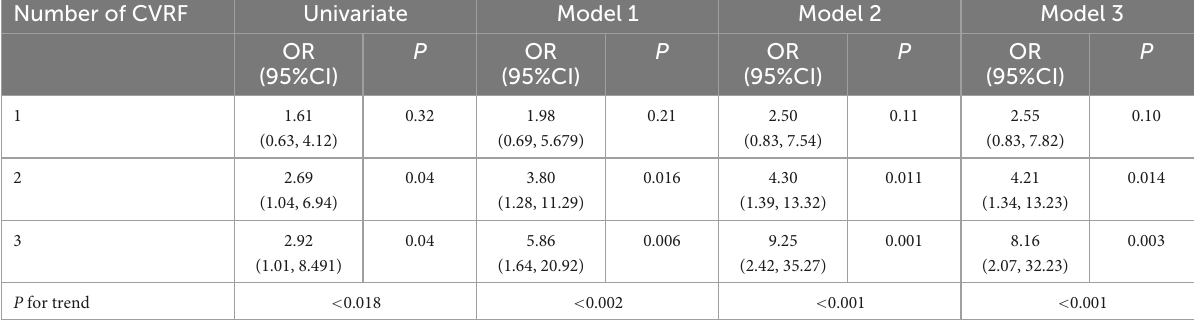
TABLE 3 Regression analysis of the number of CVRF for elderly patients with sarcopenia. Number of CVRF